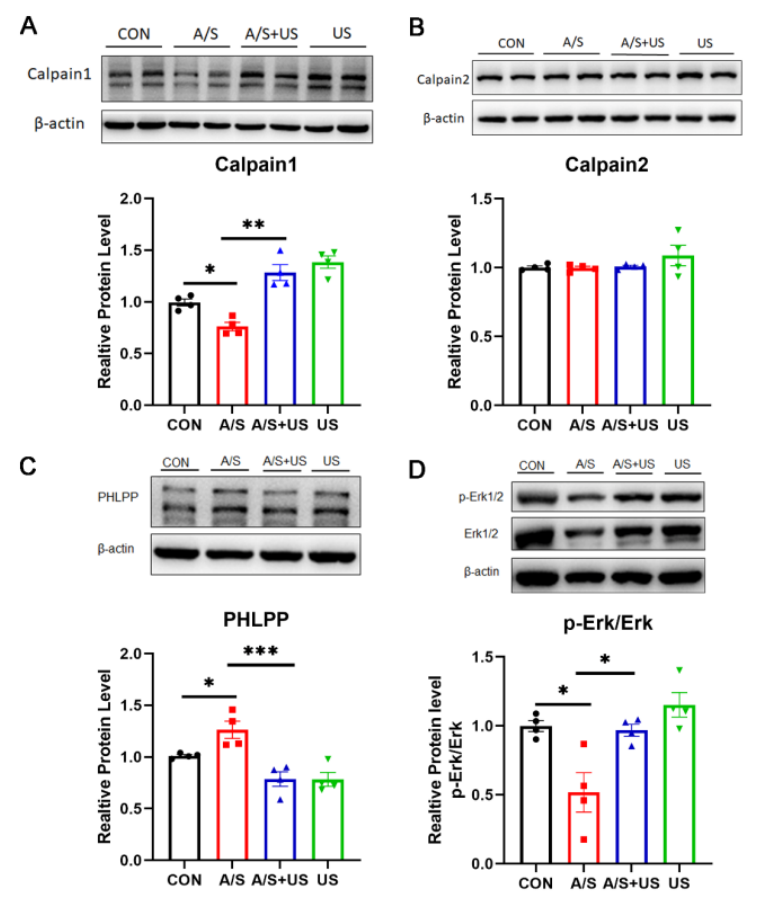
Figure 6. LIPUS may modulate the calpain1/Erk pathway to salvage synaptogenesis after anesthe- sia/surgery in aged mice. Western blotting analysis of Calpain1 ( A ) and Calpian2 ( B ) expression among the four groups. ( C ) PHLPP, as the substrate of calpain1, was used to represent the activity of calpain1. ( D ) Erk phosphorylation level was expressed as the ratio of p-Erk to total Erk and normal- ized to the internal control β -actin. n = 4 per group. Data were presented as Mean ± SEM. One-way ANOVA followed by Bonferroni’s multiple comparisons tests. * p < 0.05, ** p < 0.01, *** p < 0.001.